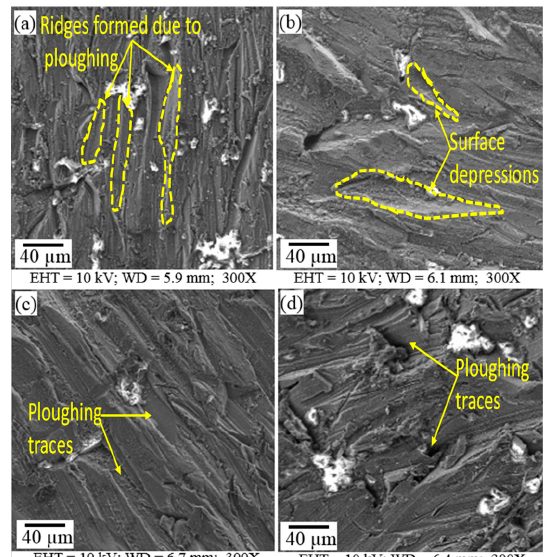
Figure 4. Surface morphological images of samples ( a ) A1; ( b ) A2; ( c ) A3; ( d ) A4 showing machined surface characteristics. Traces of ploughing are also generated on the machined Mg-6Al/1.11 Al 2 O 3 surface,